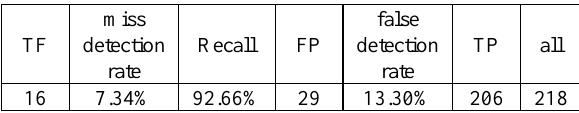
Table 2. Performance of airplane